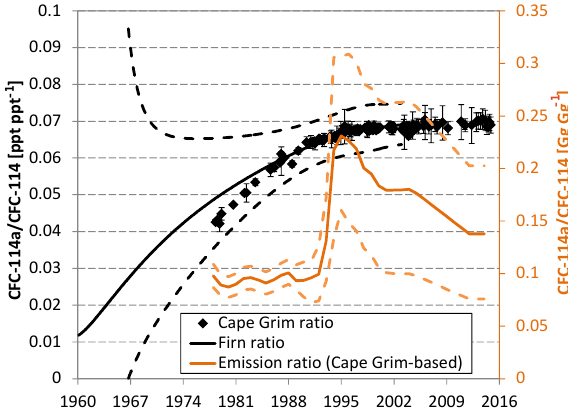
Figure 1. Mixing ratios of CFC-114 and CFC-114a as measured in air samples collected at Cape Grim, Australia, between 1978 and 2014 (diamonds) and derived from two Antarctic firn air profiles (lines). Uncertainties are 1 σ standard deviations for Cape Grim data and a combination of the former and a firn modelling uncertainty for the latter (shown as dashed lines, see text for further details).